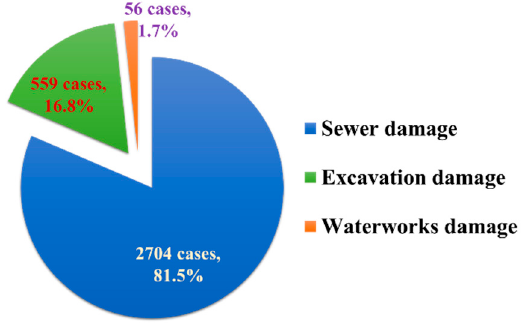
Figure 1. Causes of ground subsidence [1].